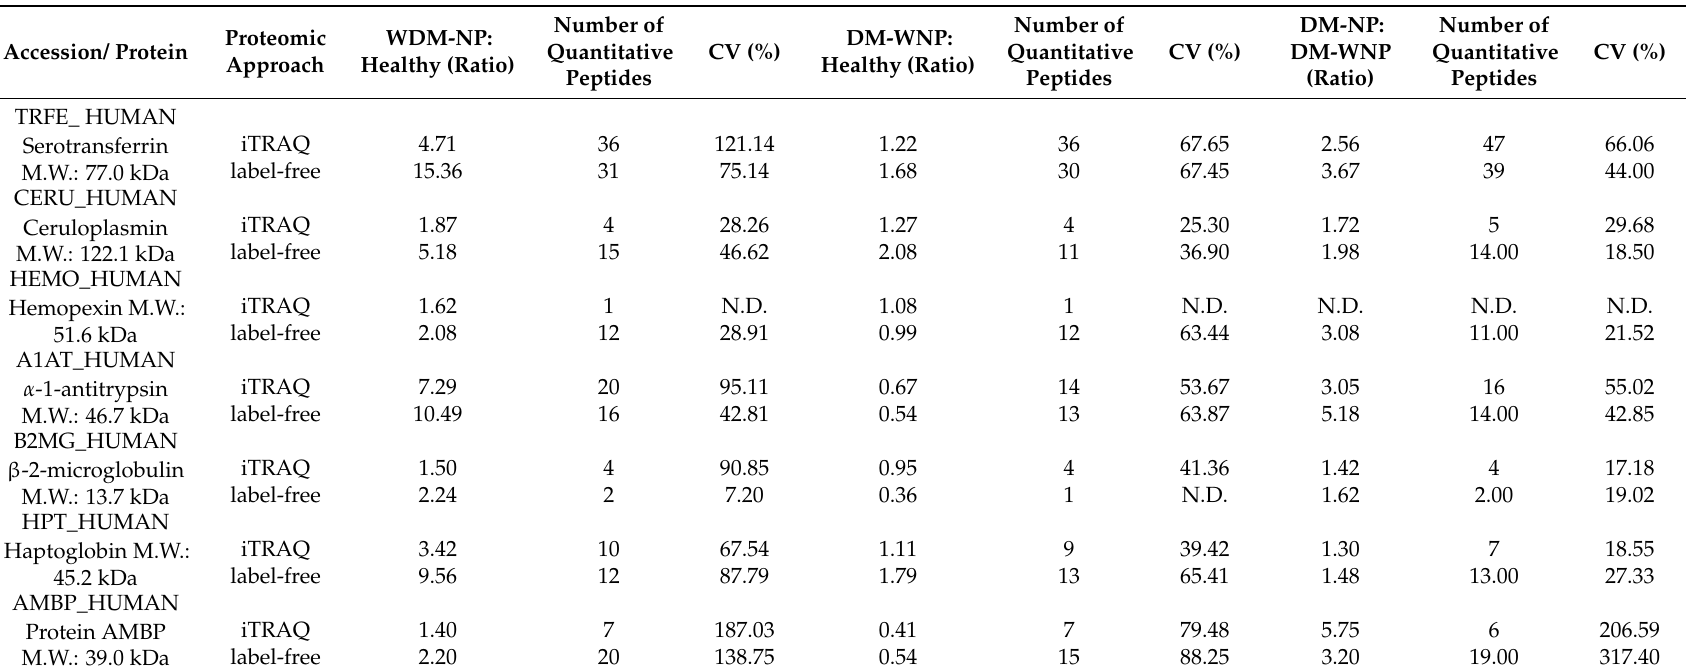
Table 1. The selected protein biomarkers identified by iTRAQ and label free proteomic approaches for ELISA